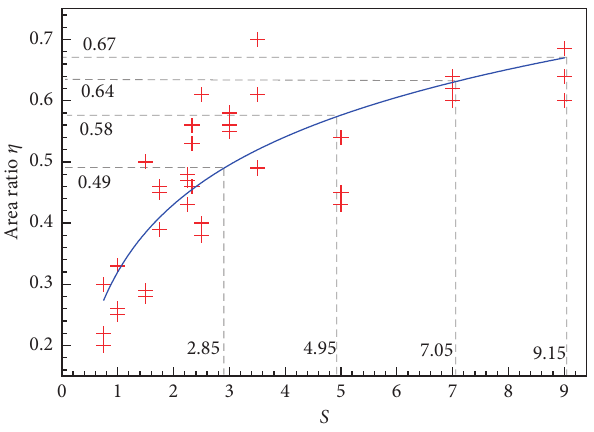
Figure 14: Fitting curve of S and η. Table 15: Test arrangement for the parameter K